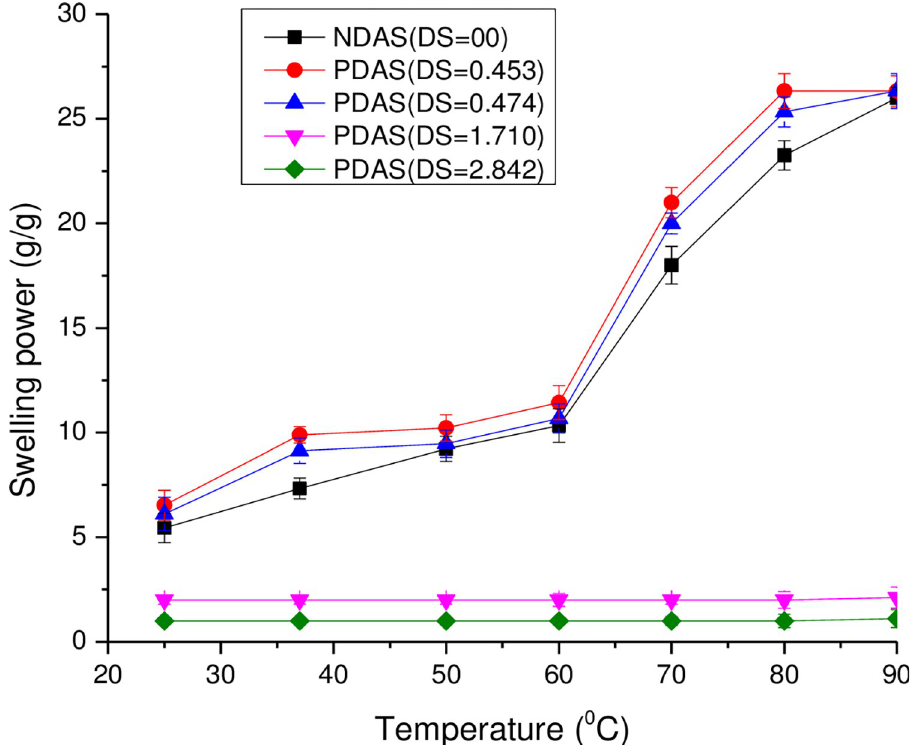
Fig 6. Swelling power of NDAS and PDAS with different DS (DS = 0.453, 0.474, 1.710, and 2.842) as a function of temperature.